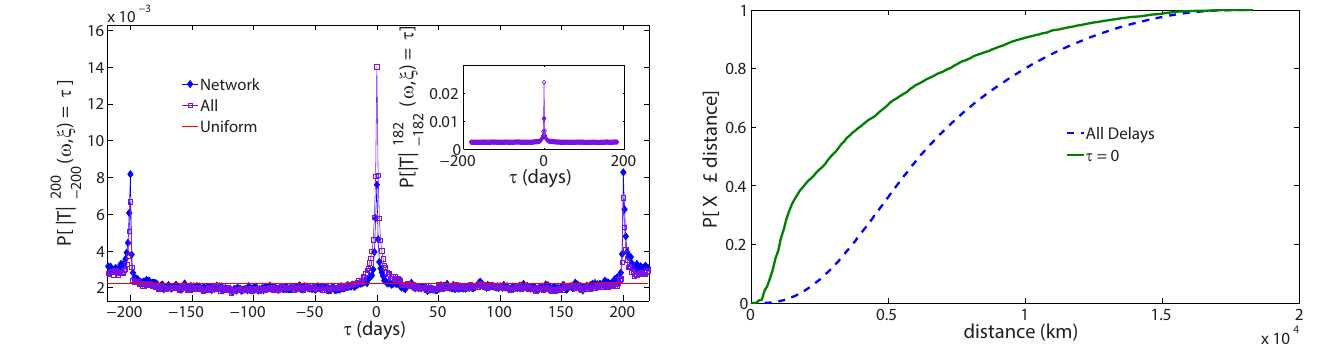
Figure 10. Examining the reanalysed network data in Fig. 9: the cumulative density function (CDF) of the distance between points where the network link has been reassigned a lag τ = 0, and the CDF of the distance between all reanalysed network links (All De- lays). We can see that points with zero time lag are closer together on average, indicating that some of these links in Fig. 9 are physi- cally